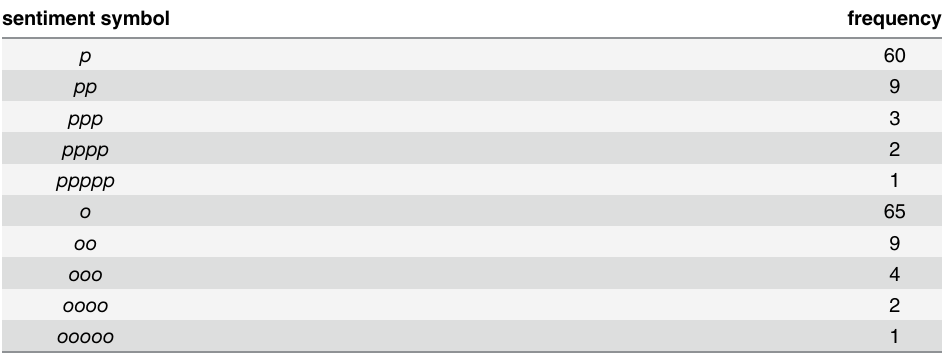
Table 4. The symbol frequency in top 25 nodes of strength degree.